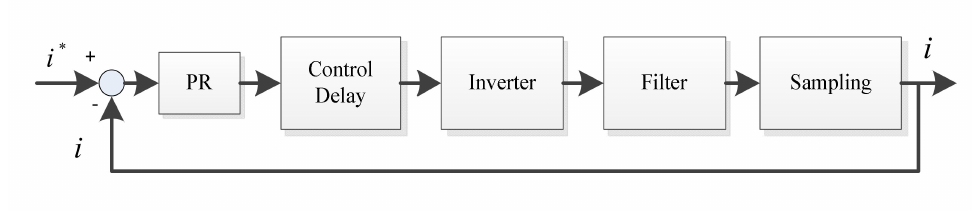
Figure 12. Block diagram of the current control